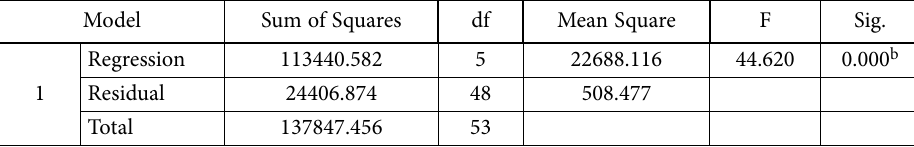
Table 4. ANOVA test afferent to the model for 2015 Model